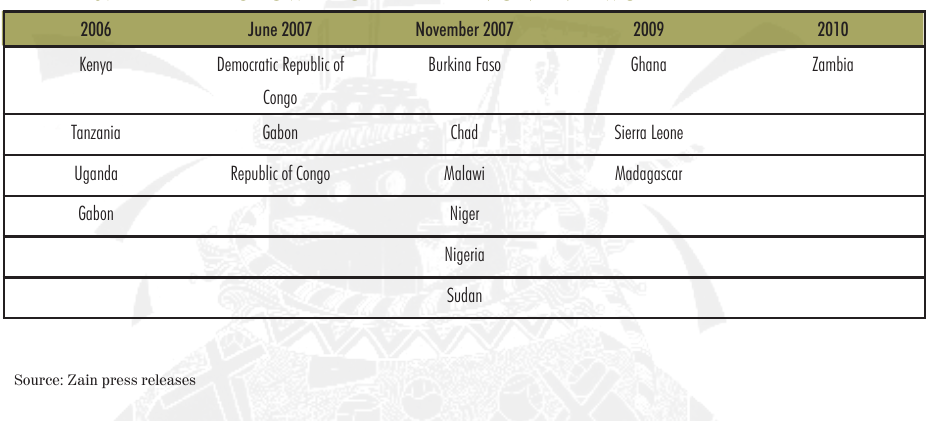
PREPAID TARIFFS OF ZAIN KENYA IN 2009 (KENYA SHILLINGS) (ZAIN, 2009) Pamoja -